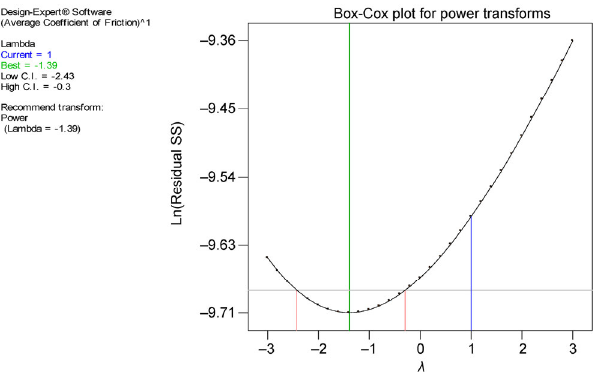
Fig. 13 Box-Cox plot for the average coefficient of friction.